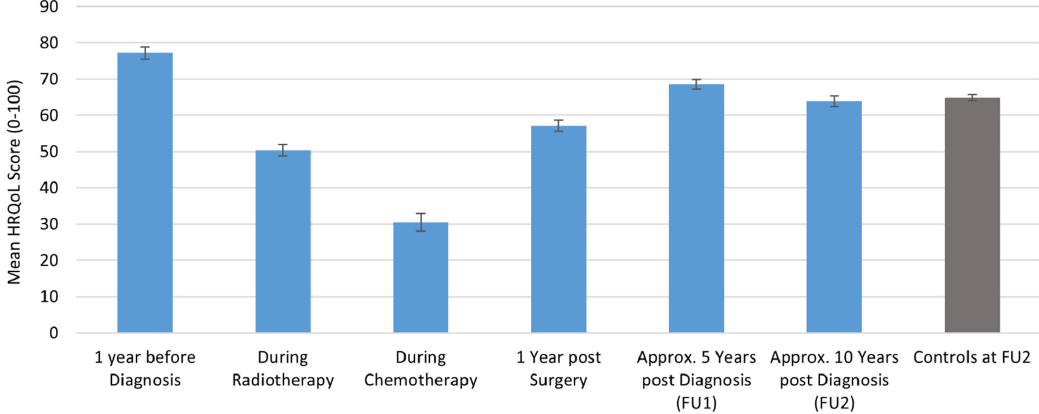
Figure 1. Longitudinal course of general HRQoL in breast cancer survivors over all age groups and compared to controls at approx. 10 years after baseline assessment.